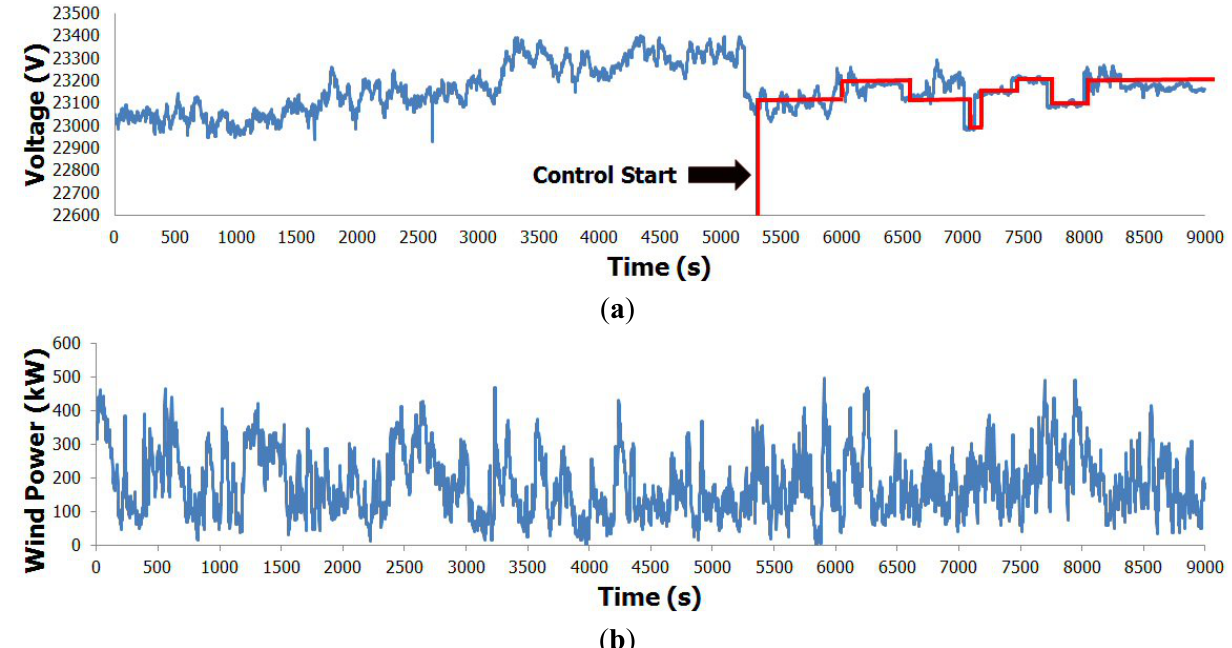
Figure 13. Test results of voltage control using VVO: ( a ) voltage control using VVO for HW13 switch of Figure 11; and ( b ) active power output of wind power.